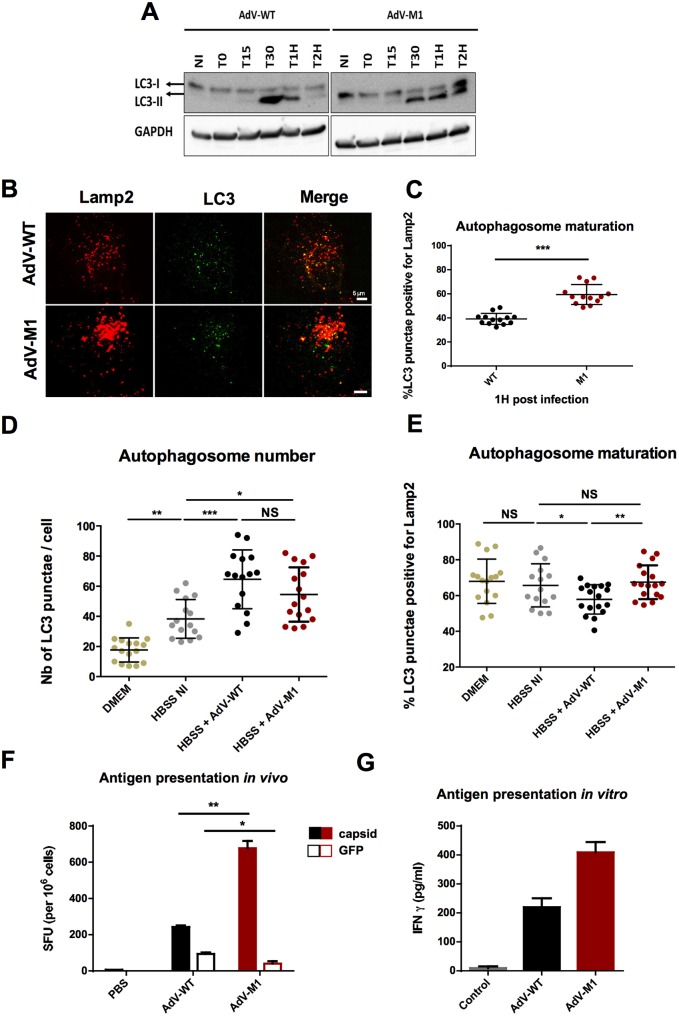
AdV-WT limits autophagosome maturation and antigen presentation.(A) Cells were infected with WT and M1 viruses for indicated time points and cell lysates were analyzed by western blot with LC3 specific antibodies. Specific LC3 bands and GAPDH loading control are indicated. (NI = non infected). (B) The panel shows representative confocal images of U2OS cells infected for 1h with WT or M1 as indicated to left of each row and stained with Lamp2 (red signal) and LC3 (green signal) specific antibodies. (C) Quantification of autolysosomes from the experiment shown in (B) comparing the percentage of LC3 punctae positive for Lamp2 in WT vs. M1 infected cells as indicated below the graph. (D) Cells were starved overnight in HBSS then infected for one hour with AdV as indicated below the graph. Samples were fixed and stained for LC3 and Lamp2. The total number of LC3 punctae per cell at 1hpi is shown. (NI = non infected, DMEM = non starved control cells). (E) Experiment as in (D) showing the percentage of LC3 punctae also positive for Lamp2 (n>13 cells; NS: no significant; *: P<0.05; **: P<0.01; ***: P<0.001). (F) Mice were infected with 1010 GFP expressing vector particles of WT, M1 or PBS control. 10 days post infection mice were sacrificed and splenocytes were stimulated with AdV-luc or GFP purified from E.coli. IFNγ was determined by ELIspot. (G) CD4+ T-cell clones recognizing a conserved AdV hexon epitope were incubated 3:1 with syngeneic APCs transduced with either control media or WT or M1 vectors for 24 hours. IFNγ secretion was quantified by ELISA. (see also S5 Fig).